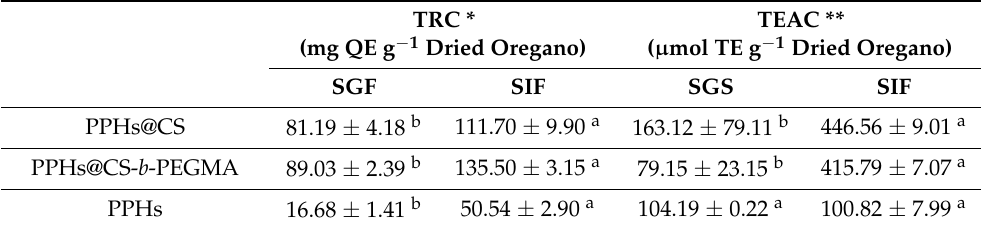
Table 4. Results of the total reducing capacity (TRC) and Trolox equivalent antioxidant capacity (TEAC) of phenolic compounds loaded in chitosan (PPHs@CS), phenolic compounds loaded in CS- block-poly(PEGMA) (PPHs@CS- b -PPEGMA), and non-encapsulated phenolics (PPHs) after gastric and intestinal in-vitro digestion. TRC * TEAC ** (mg QE g − 1 Dried Oregano) ( µ mol TE g − 1 Dried Oregano) SGF PPHs@CS 81.19 ± 4.18 b PPHs@CS- b